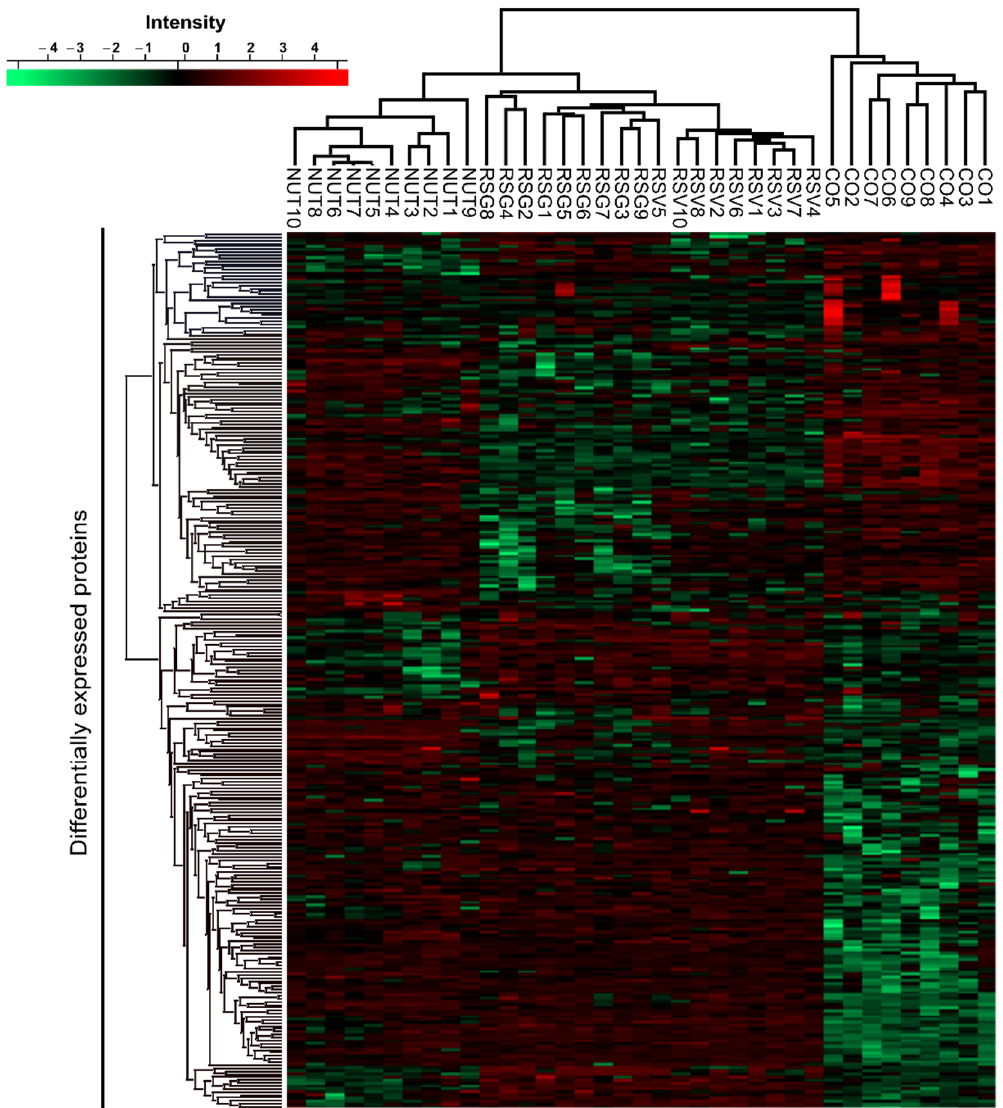
Figure 2. Differentially expressed proteins (DEPs) in lasered retinas of mice supplemented with RSG, NUT, and RSV nutraceuticals. Heatmap of DEPs. Hierarchical clustering was performed on logarithmized LFQ intensities after z-score normalization of the data, using Euclidean distances (ANOVA test, FDR < 0.05, S0 = 1). Red indicates a high expression level and green a low expression level.